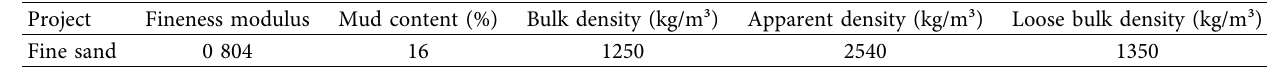
Table 5: Physical index of fne sand.